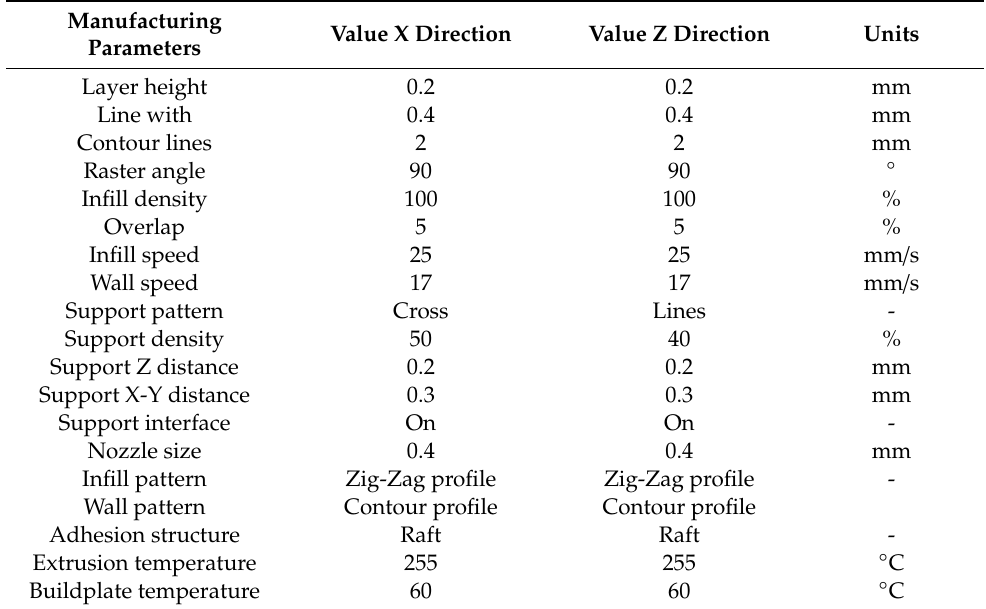
Table 3. Manufacturing parameters of the FDM process for the 3D printed parts.